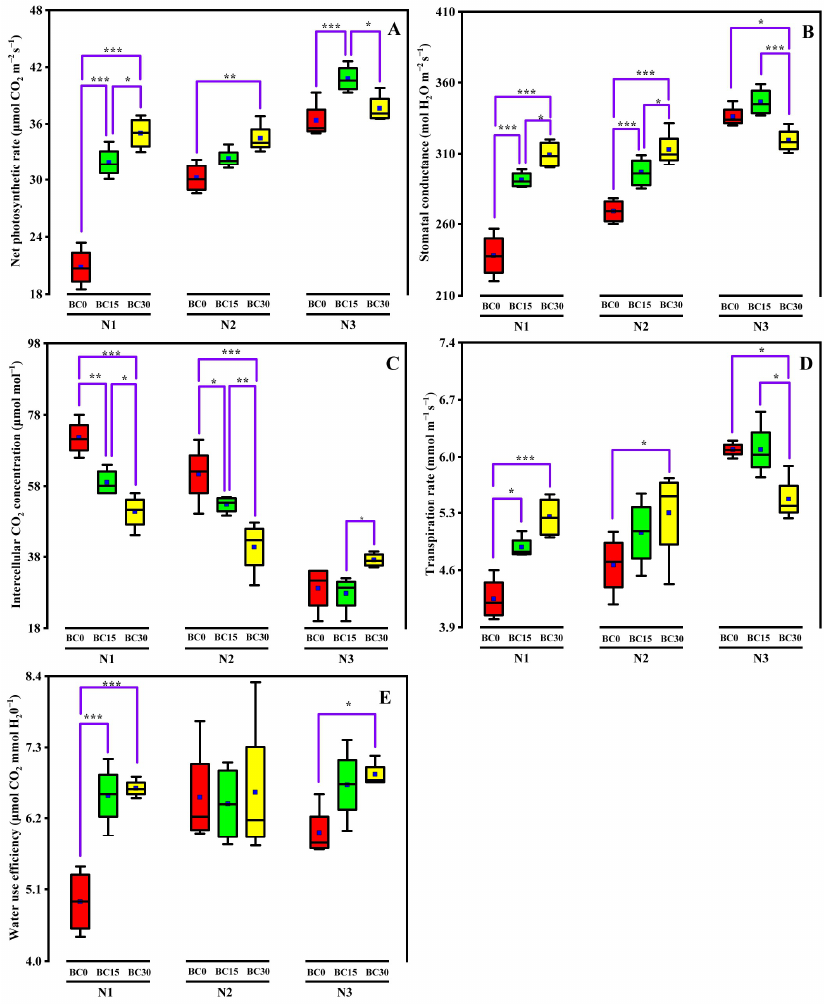
Figure 2. Effects of biochar on net the photosynthetic rate ( A ), stomatal conductance ( B ), intercellular CO 2 concentration ( C ), transpiration rate ( D ) and water use efficiency ( E ) in leaves of maize under different nitrogen fertilizer conditions. Significance levels are indicated: * p < 0.05, ** p < 0.01, *** p < 0.01.